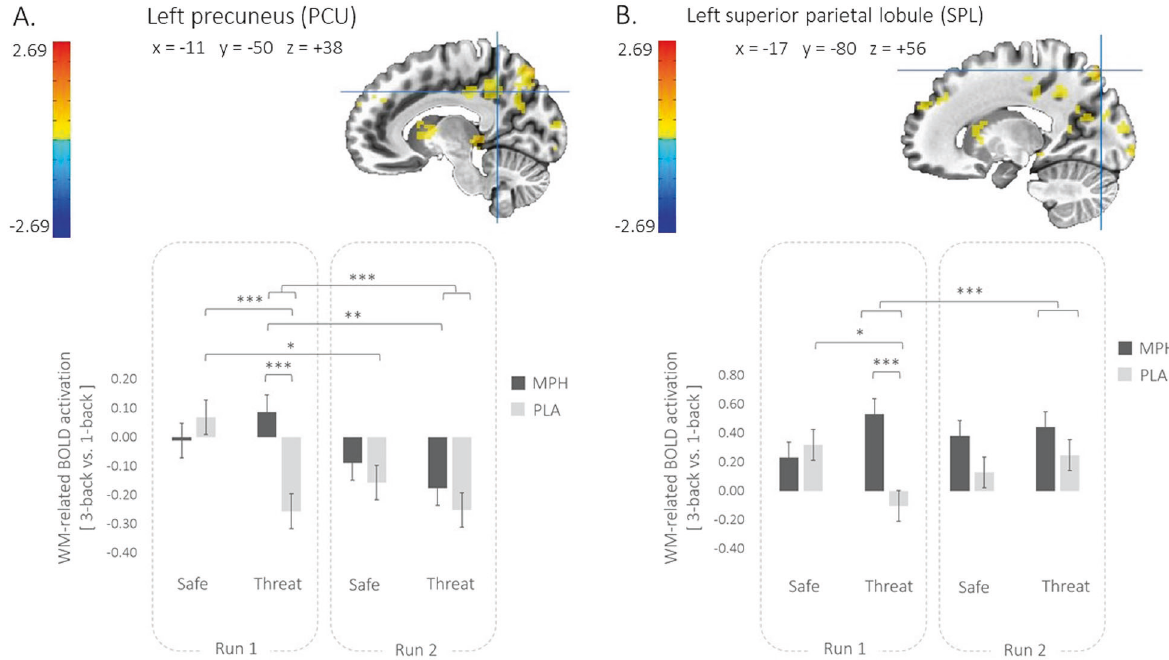
Fig. 3 Interaction effect of Drug , Run , and Condition on WM-related BOLD activation in left precuneus (PCU) and left superior parietal lobule ( SPL ). Upper panel: Drug by Run by Condition interaction on WM-related BOLD (3-Back vs. 1-Back contrast) recruitment of the A left PCU and B left SPL. Lower panel: Histograms of the parameter estimates extracted from the A left PCU and B left SPL. Linear mixed-effects models were conducted on the parameter estimates with Drug , Run , and Condition as fi xed factors, and Subjects as random factor. Sex and Age were included as covariates. Error bars represent mean ± standard error of the mean. Color bar: warm colors represent WM-related BOLD activation in MPH compared to PLA, while cool colors represent WM-related BOLD activation decrease in MPH compared to PLA. Crosshairs depict the location of the voxel with the peak activation for the given cluster. Wholebrain activations are corrected for multiple comparisons using a cluster-based approach with a voxel-wise bi-sided p -value threshold of p < 0.001 and a minimum cluster size of k = 16 (432 μ L), which corresponds to a cluster-level alpha of p < 0.05 using NN2 clustering, where clustered voxels can share faces and edges. For visualization purpose, whole-brain activationsare thresholded here at p = 0.01. * p < 0.05, ** p < 0.01, *** p <